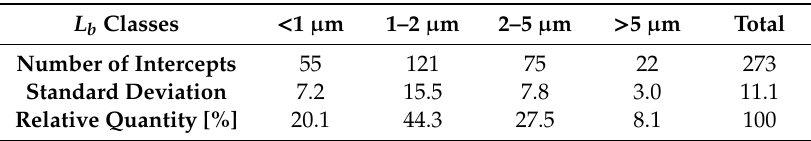
Table 4. Results of the mean free path L b evaluation by intercept method.